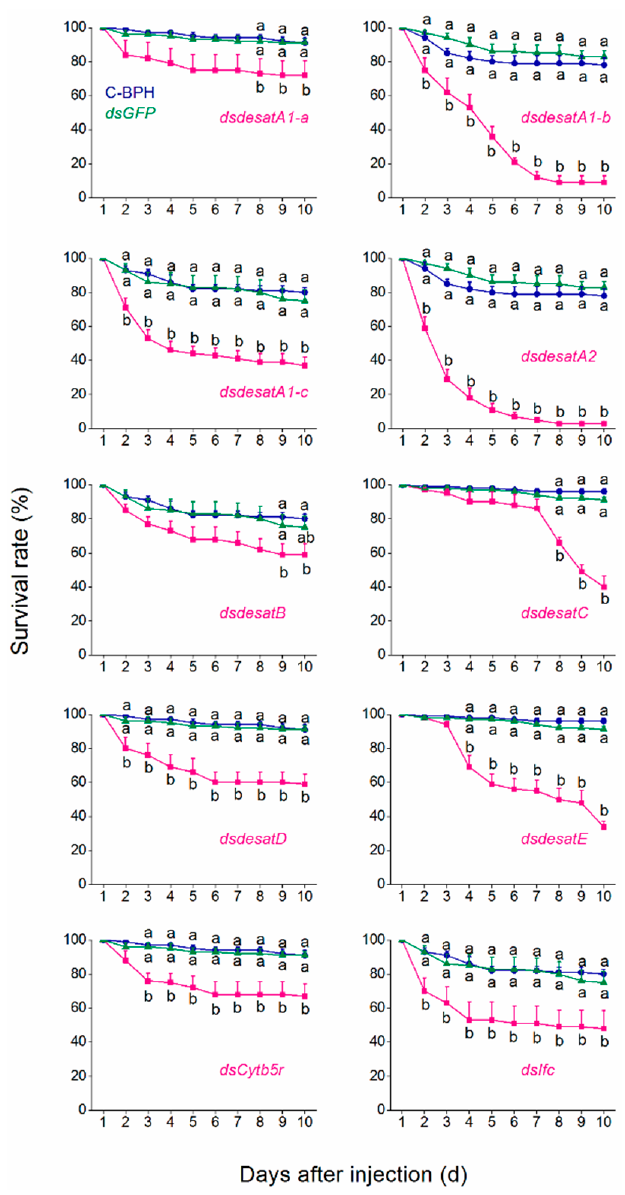
Figure 8. The effect of single knockdown of Nlug-desat s on BPH nymph survival. Mean survival rate (+SE, n = 5) of BPH injected with the dsRNA of 10 N.lugens desaturase genes or GFP ( dsGFP ), or kept non-injection (C-BPH). Letters indicate significant differences among different treatments ( p < 0.05, one-way ANOVA followed by Duncan’s